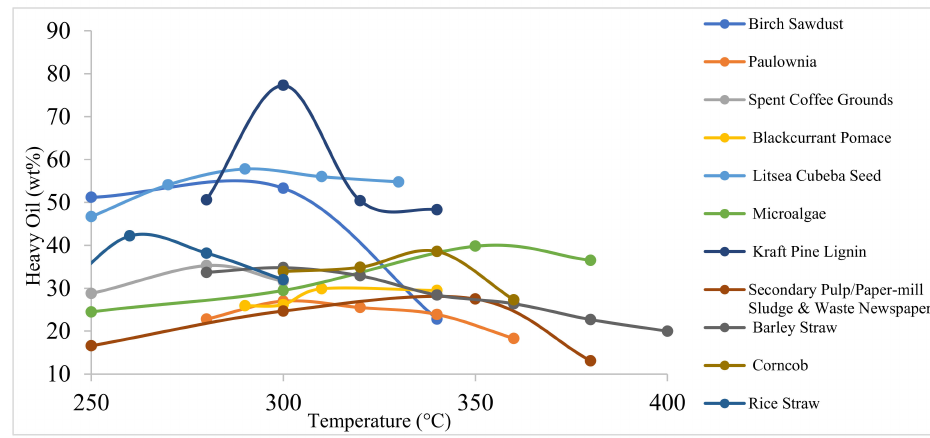
Figure 5. Effect of final temperature on the yield of heavy oil for various feedstocks.